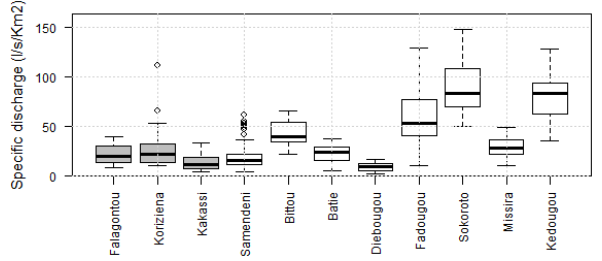
Figure 3. Boxplots of specific Qmax of each catchment within the period 1970–2010. The boxplot represents the median on the middle hinge and the 25th (75th) percentile on the lower (upper) hinge. The lower (upper) whisker is the border beyond which outliers are considered to be equal to 1 . 5 × interquartile range − 25th ( + 75th). Empty circles represent outliers greater than the upper whisker or below the lower whisker. The three first boxes represent the time series for Sahelian catchments.